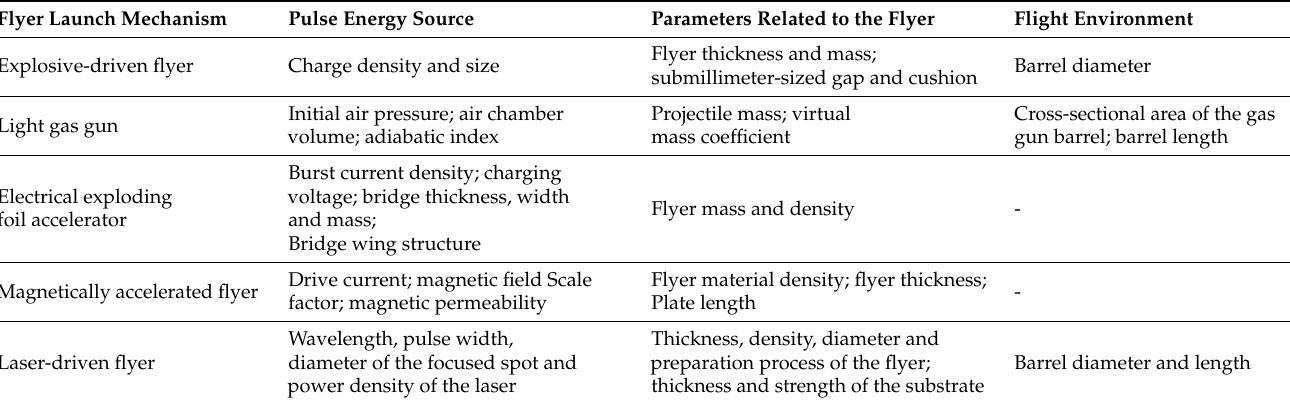
Table 3. Influence factors of flyer speed mentioned in the literature.